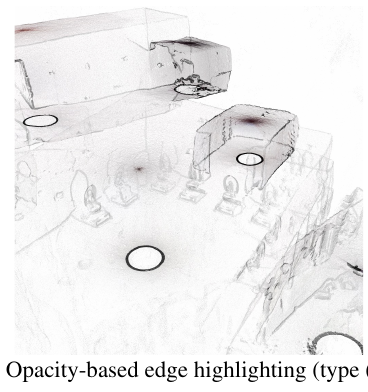
Figure 8. Comparative visualizations of the prayer chapel in the Zuiganji Buddhist Temple (1): (a) The ordinary transparent visualization by SPBR without edge highlighting. (b) Opacity-based edge highlighting (type